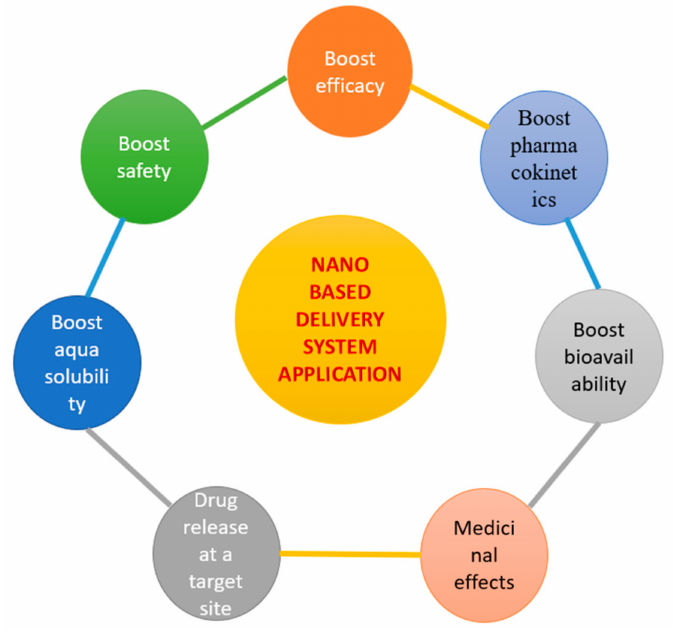
Figure 1. Benefits of nanodelivery